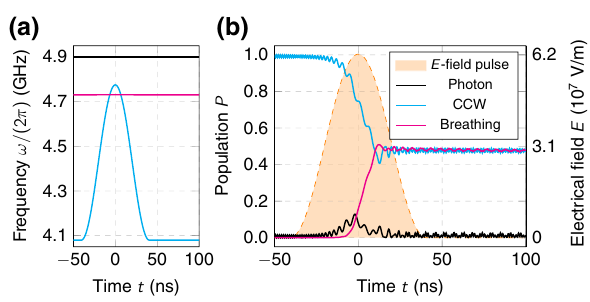
FIG. 6. A SPLIT operation of magnons mediated by photons in the SkX phase of Cu 2 OSeO 3 under a full-period cosine E - field pulse. (a) Time dependence of the bare photon frequency (black) and bare frequencies of the CCW (cyan) and breathing (magenta) modes. (b) Time dependence of the modes’ popula- tion upon the electric field pulse. The quantum information of a maximally populated CCW mode (cyan) gets split into two parts (cyan and magenta). Losses are associated with the photon damp- ing; magnon damping is set to zero. For the parameters used, see the